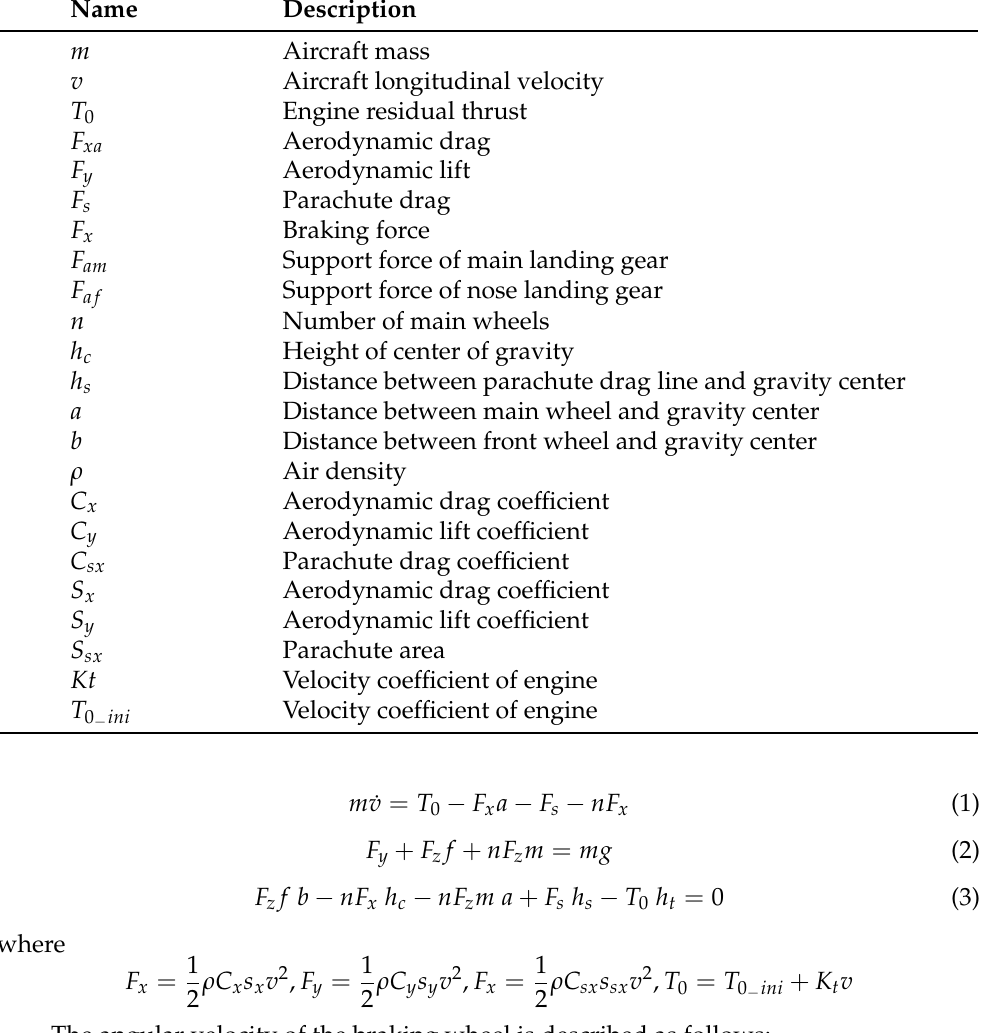
Table 1. Parameters for the aircraft model.